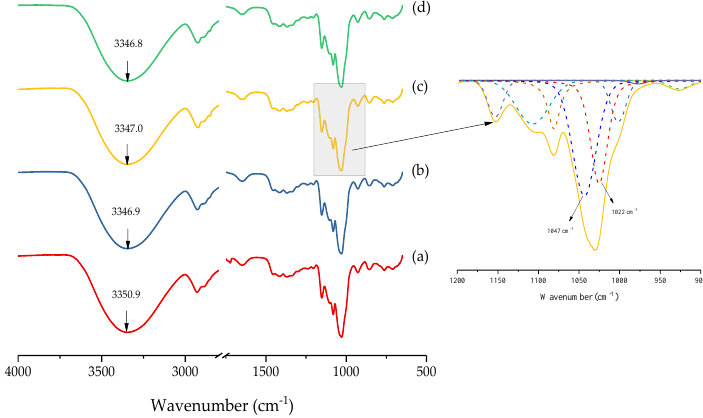
Figure 7. Fourier Transform Infrared Spectroscopy (FT-IR) spectra of (a) HPDSP-Na; (b) HPDSP-1231; (c) HPDSP-1631; and (d) HPDSP-1831 and a magnified view of the peaks between 1200 to 900 cm − 1 from HPDSP-1631 spectrum (on the right).